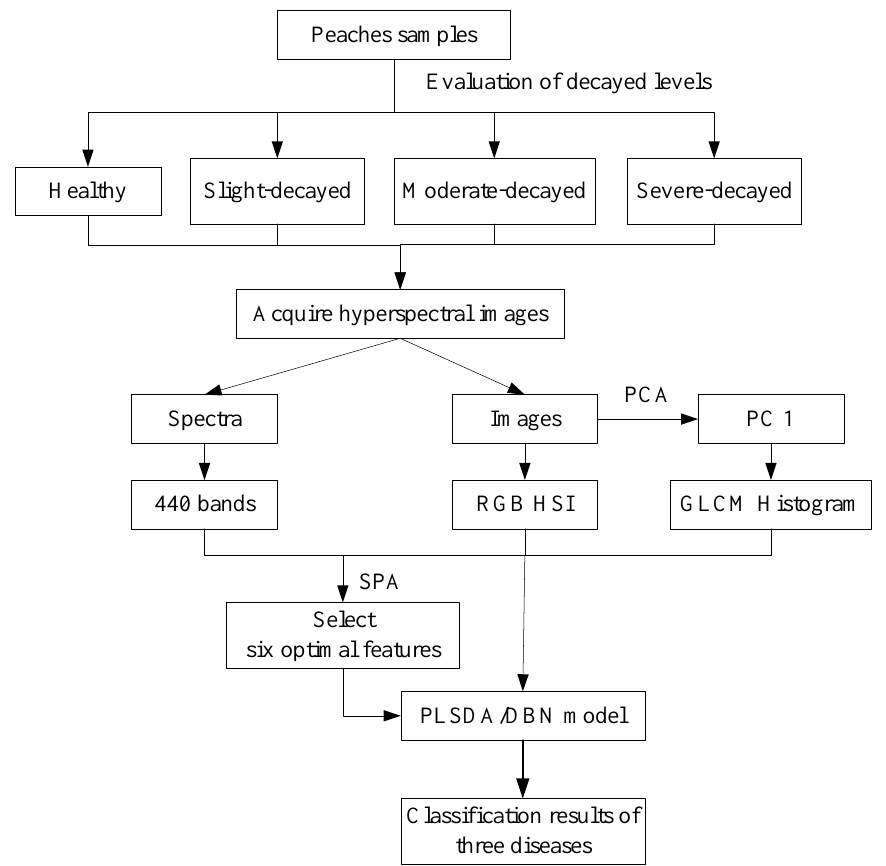
Figure 1. Flowchart of the data analysis procedures used to classify different fungal diseases. (PCA: principal components analysis; PC1: first principal component image; SPA: successive projections algorithm; RGB: red, blue, and green; HIS: hue, saturation, and lightness; GLCM: gray level co-occurrence matrix; PLSDA: partial least squares discrimination analysis; DBN: deep belief network).